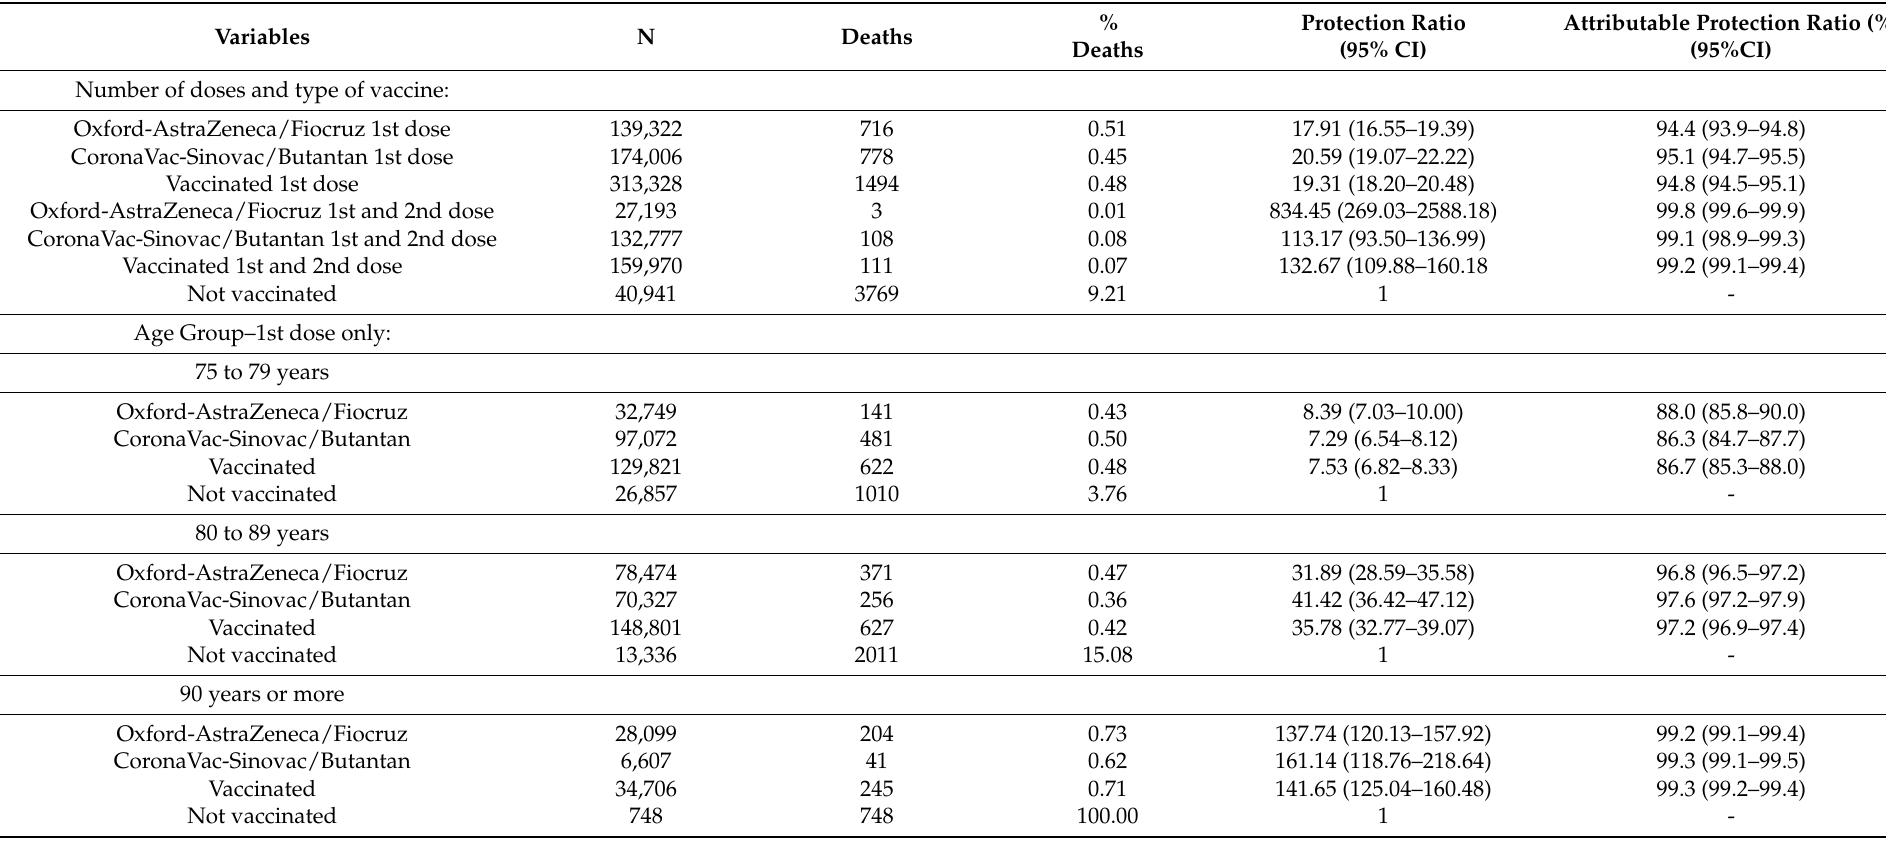
Table 1. Protection ratios for death and percentage attributable protection ratios for deaths by COVID-19, stratified by number of doses applied, vaccine type and age group over 75 year-olds in the state of Cear á , Brazil, 2021.